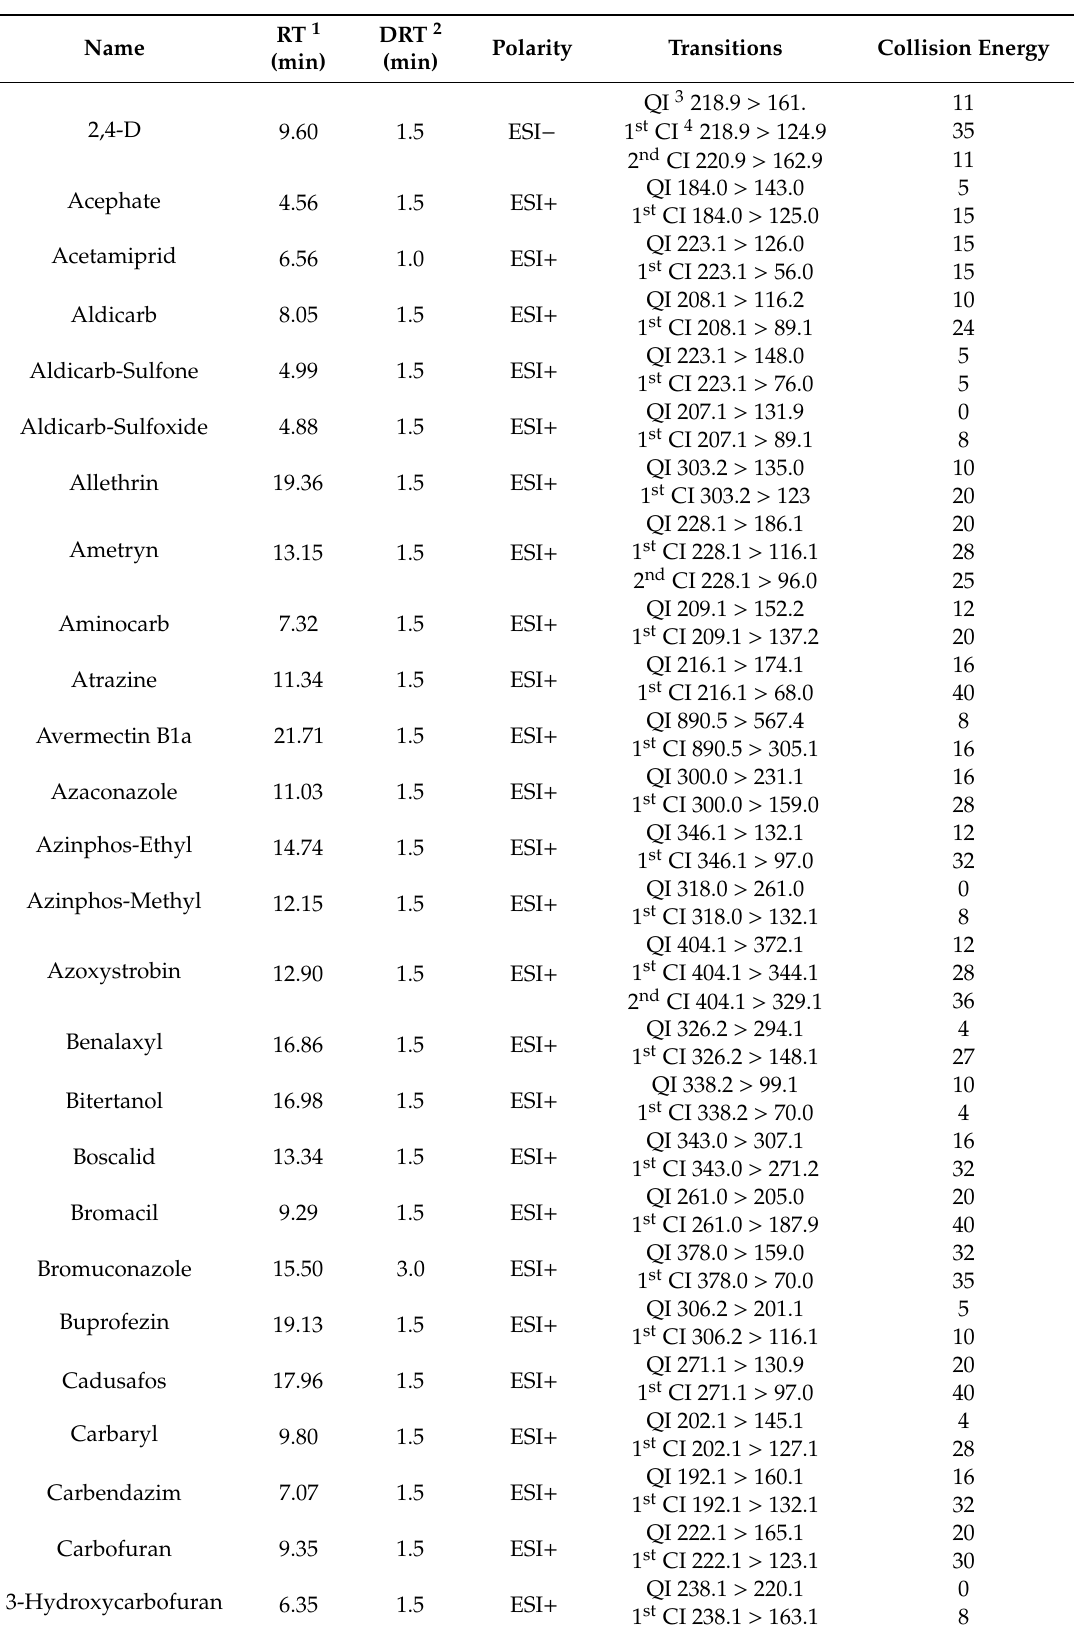
Table 1. Chromatographic parameters and MS / MS (tandem mass spectrometric) detection